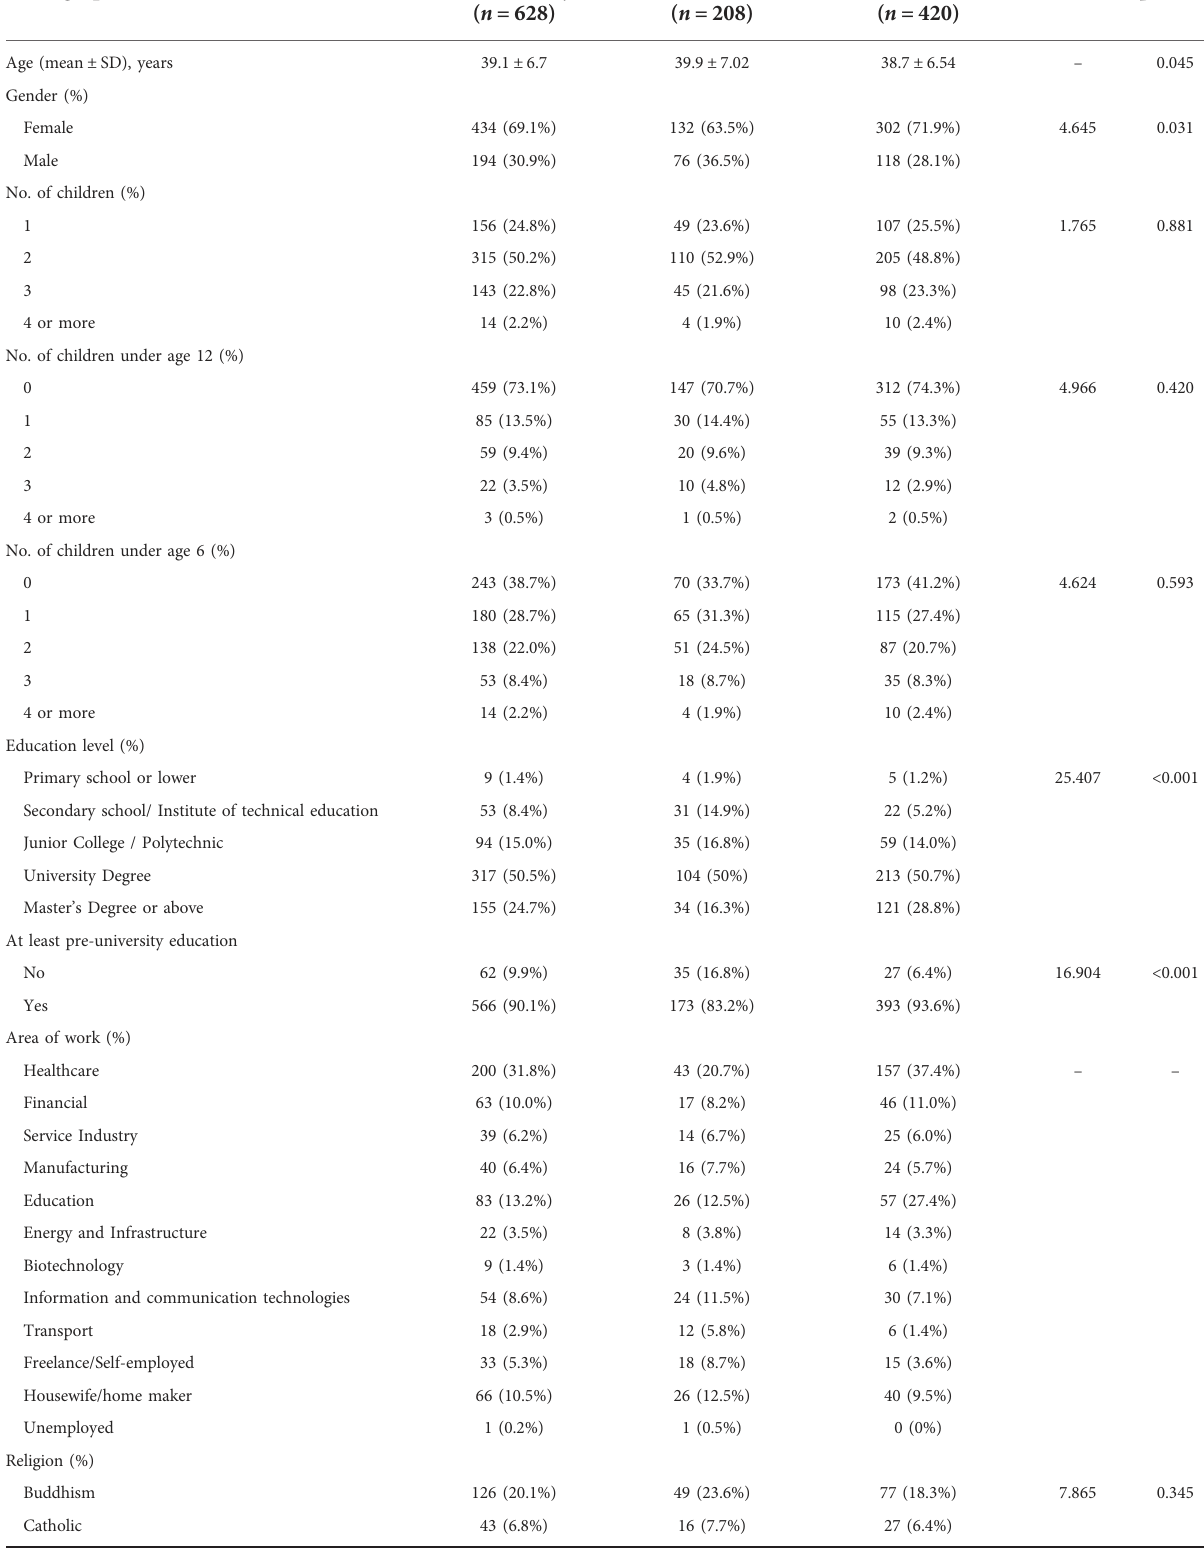
TABLE 1 Demographics of participants and comparison of the vaccine hesitant vs. non-hesitant